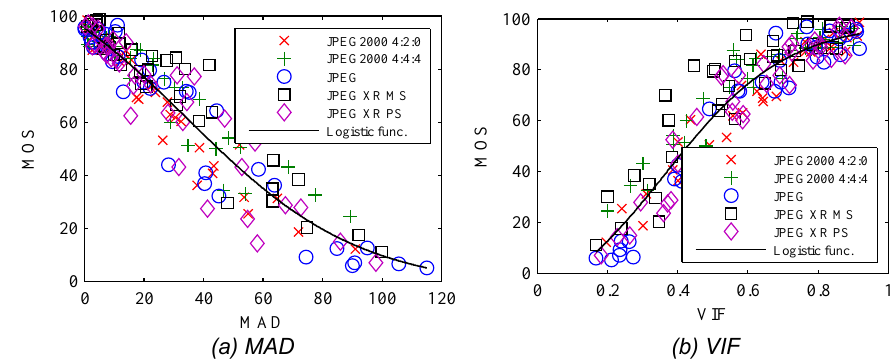
Figure 6 – Scatter plots of subjective (MOS) versus objective quality predictions on the JPEG XR Image